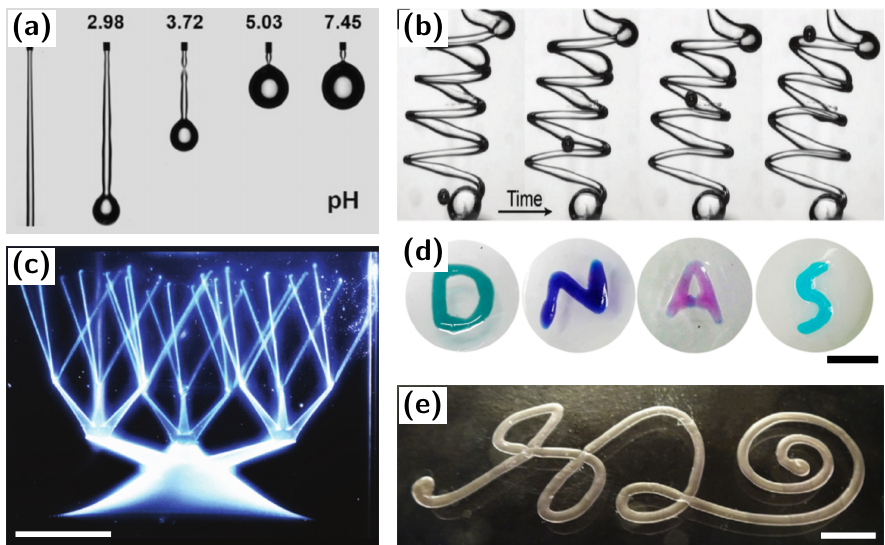
Figure 1. 3D printing of structured liquids. ( a ) Break-up length variation of an aqueous cellulose nanocrystals solution falling in toluene that contains PS-NH 2 with different pH values. The Plateau–Rayleigh instability effect is greatly inhibited by the stronger electro-static attraction force between the polymer ligand and nanoparticles at lower pH. ( b ) 3D printing of nanoparticle surfactant-stabilized aqueous threads in a silicone oil. ( c ) Complex patterns can be printed into granular gel media by injection using microscale capillary tips. Scale bar is 10 mm. ( d ) DNA surfactants molded by the interfacial jamming of DNAS. Scale bar is 10 nm. ( e ) 3D printing of water in water construct stabilized by an elastic polyanion-polycation coacervate membrane. Scale bar is 5 mm. Figures adapted from References [4,6,27,29,30].